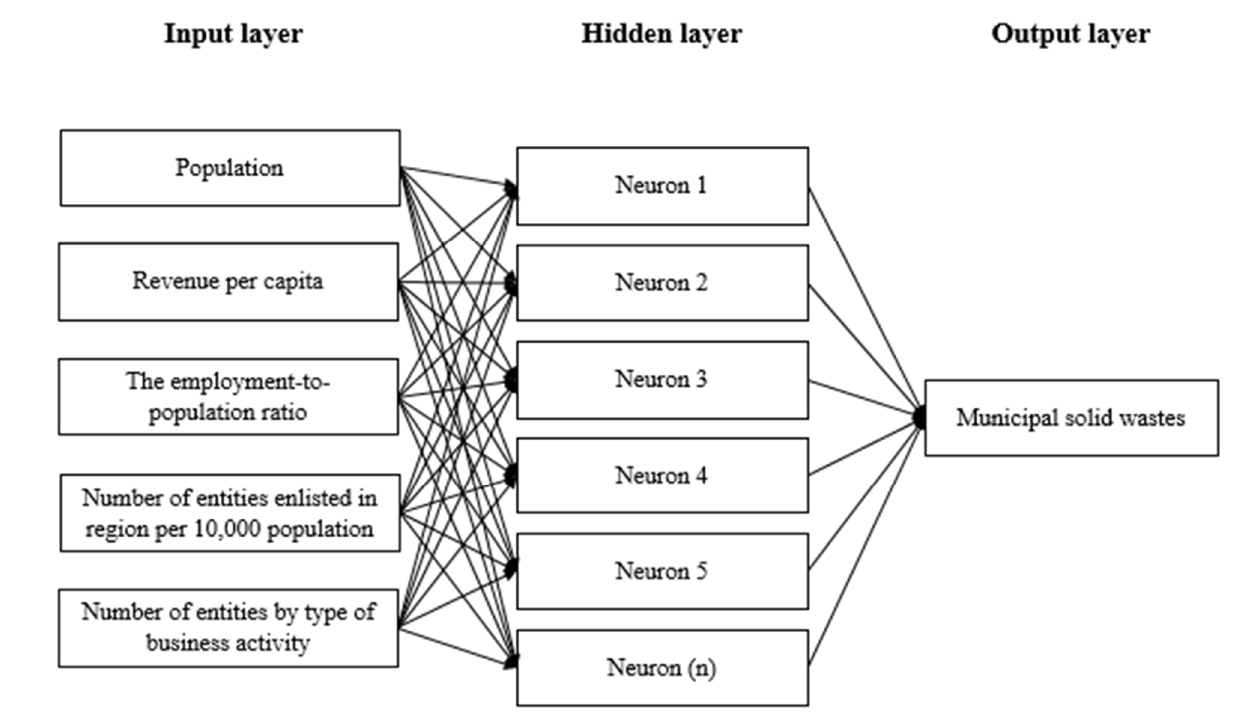
Figure 1. Structure of a neural network.